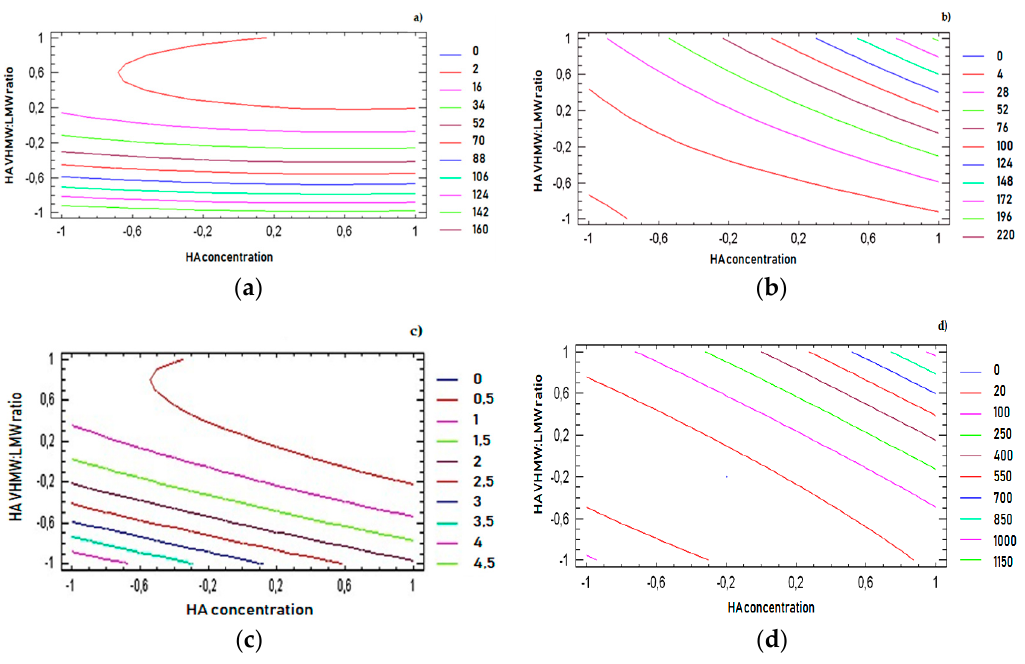
Figure 3. Standardized Pareto chart of the effect of each factor and that of their interactions on each response variable of the full factorial design: ( a ) frequency at cross over, ( b ) viscosity at cross over, ( c ) tan δ at 2.5 Hz, ( d ) dynamic viscosity in rest condition (0.01 s − 1 shear rate). A = HA concentration; B =